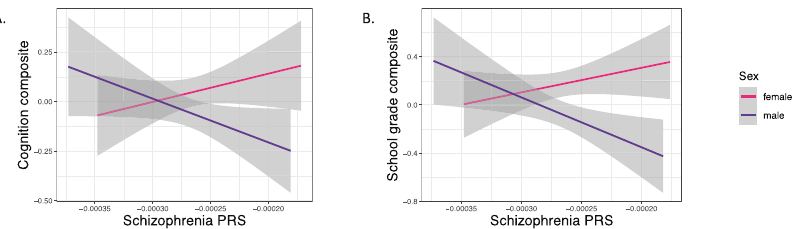
Fig. 2 Association between schizophrenia PRS and baseline cognitive test performance cross-sectionally in males and females. A PRS associated with a cognition composite score that was calculated as the sum of z-transformed tests of visuospatial ability, episodic memory, and semantic memory (males: t -value = − 3.397, p -value = 0.0007); females: t -value = 0.612, p -value = 0.5404). B PRS associated with a school grade composite score that was calculated as the sum of z-transformed school grades from six school subjects: mathematics, Swedish, history, biology, geography, and scripture knowledge (Christianity) (males: t -value = − 2.707, p -value = 0.0073; females: t -value = 0.296, p -value = 0.7673). Gray areas indicate standard error. PRS p -value threshold ≤